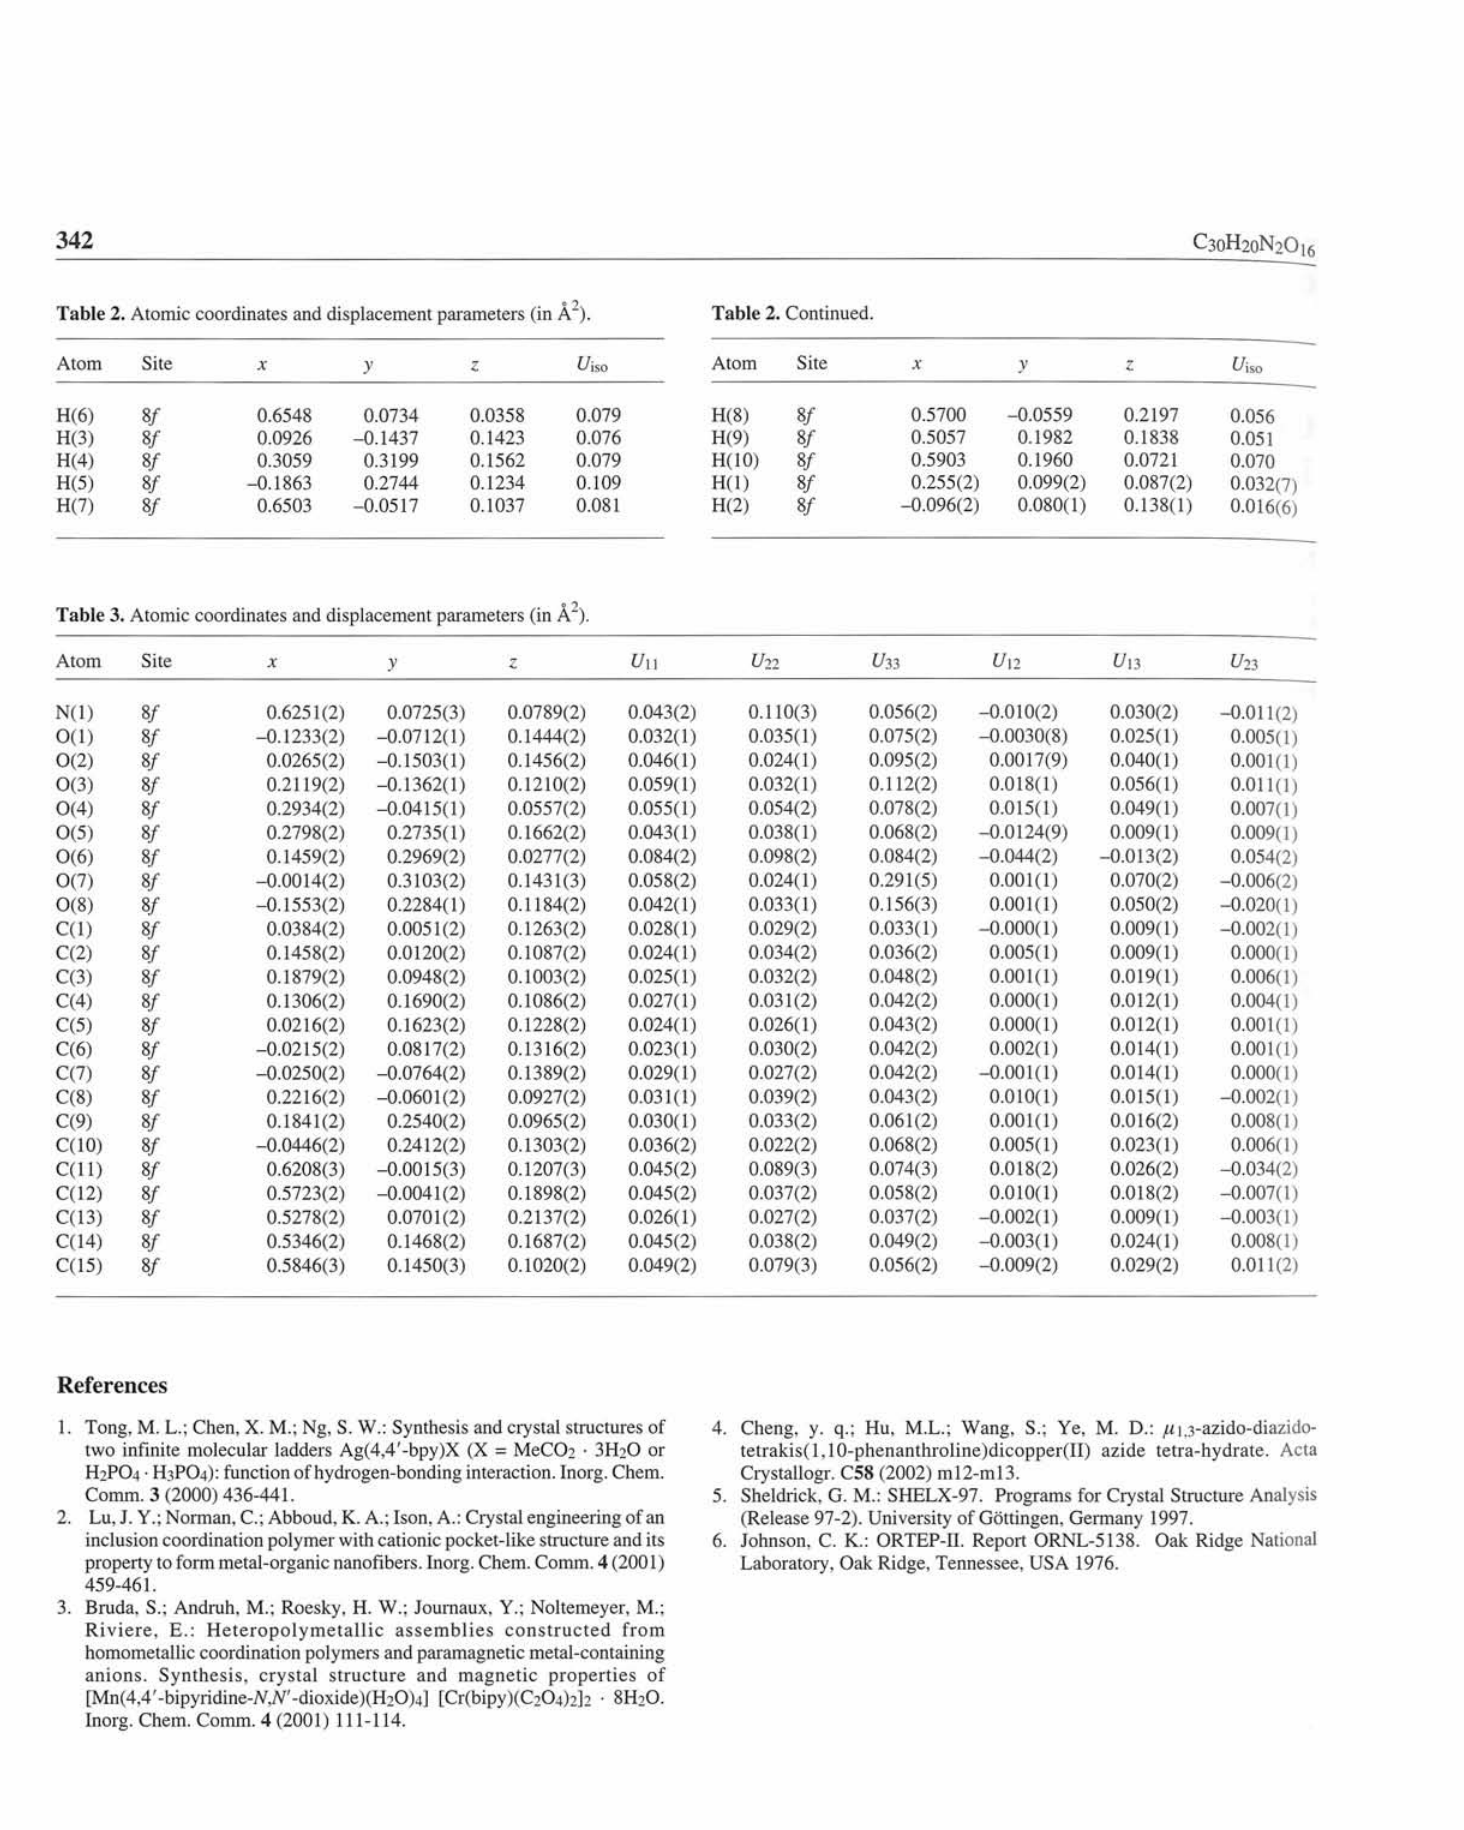
Table 3. Atomic coordinates and displacement parameters (in À 2